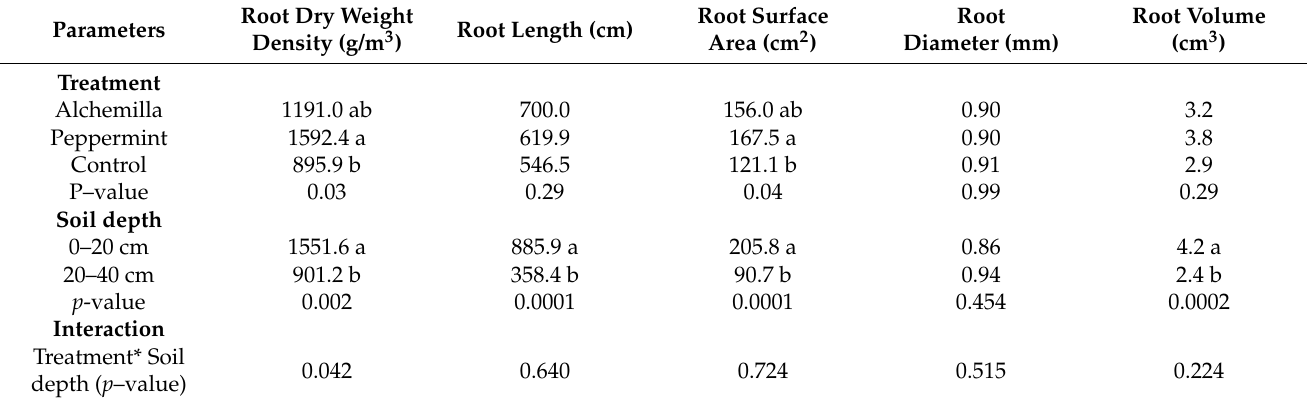
Table 3. Effect of living mulches, soil depth, and their interactions on the density and morphological parameters of the total root community (herbaceous and apple roots).